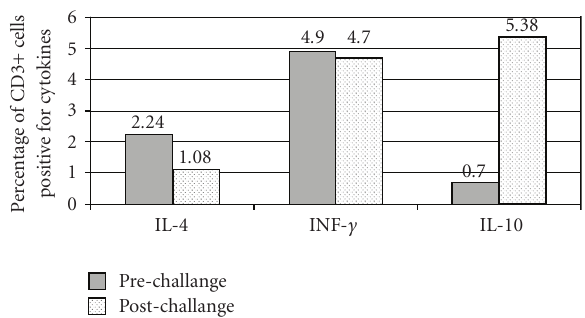
Figure 2: Cytokines expression levels before and after a challenge with rice in the same child became tolerant to the food six months